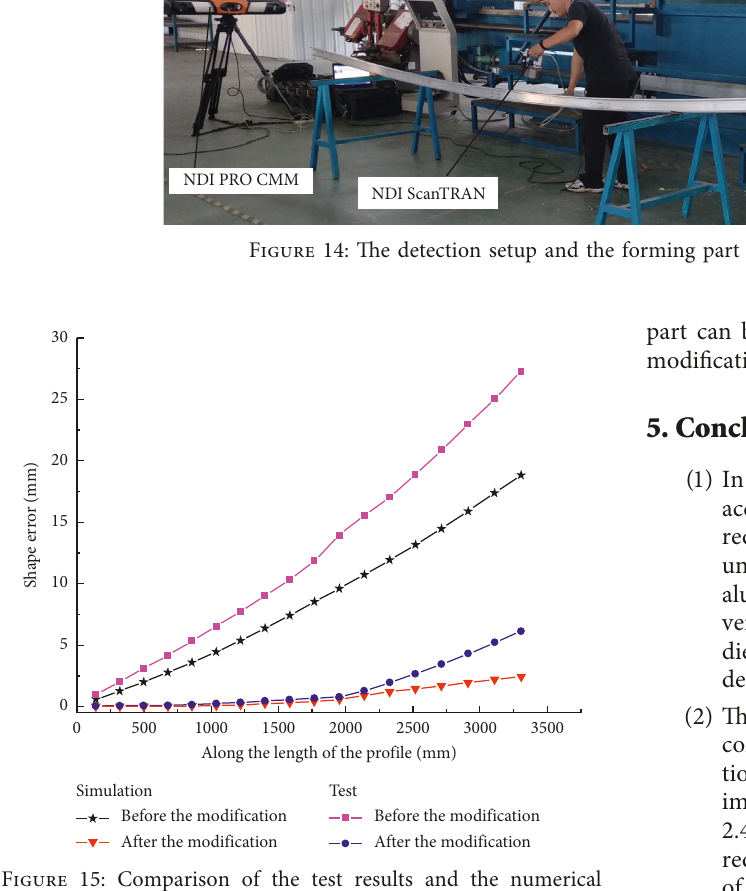
Figure 15: Comparison of the test results and the numerical simulation